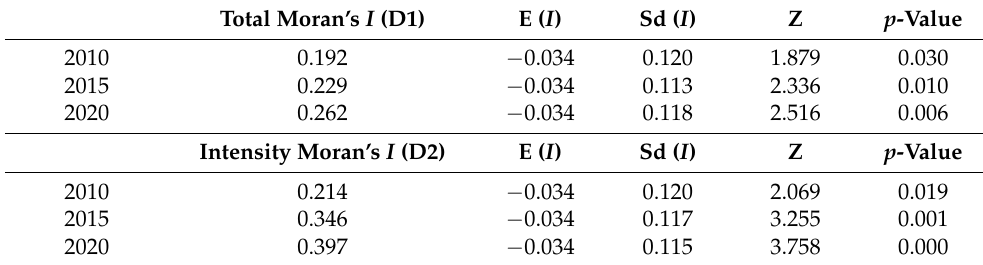
Table 5. Global Moran’s I of coupling coordination degree.